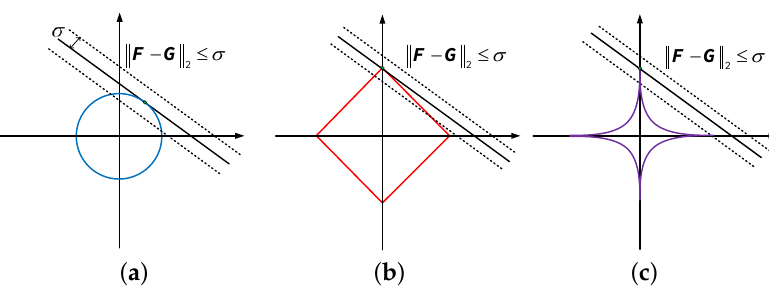
Figure 1. Feasible domain of R ApTV ( F ) : ( a ) p = 2, ( b ) p = 1 and ( c ) 0 < p <